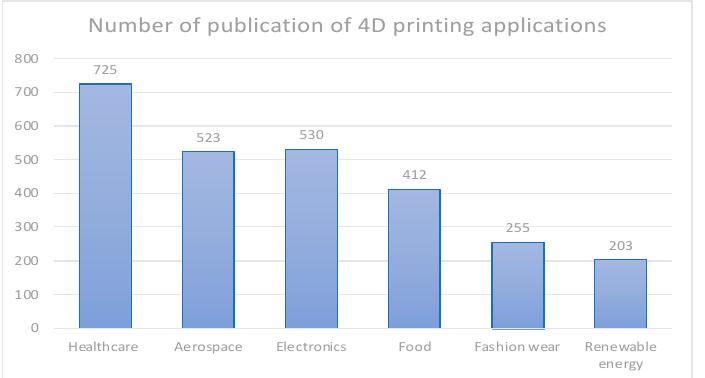
Figure 6. Estimated number of publications of 4D printing applications in several disciplines between 2013 and 2022 in the ScienceDirect database (as of 30 November